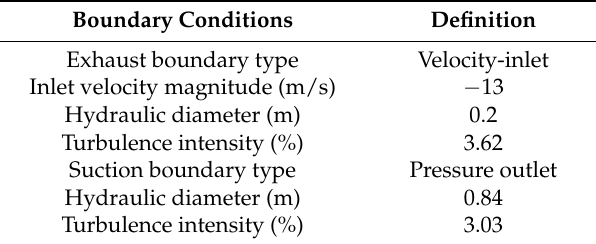
Table 1. Boundary conditions.